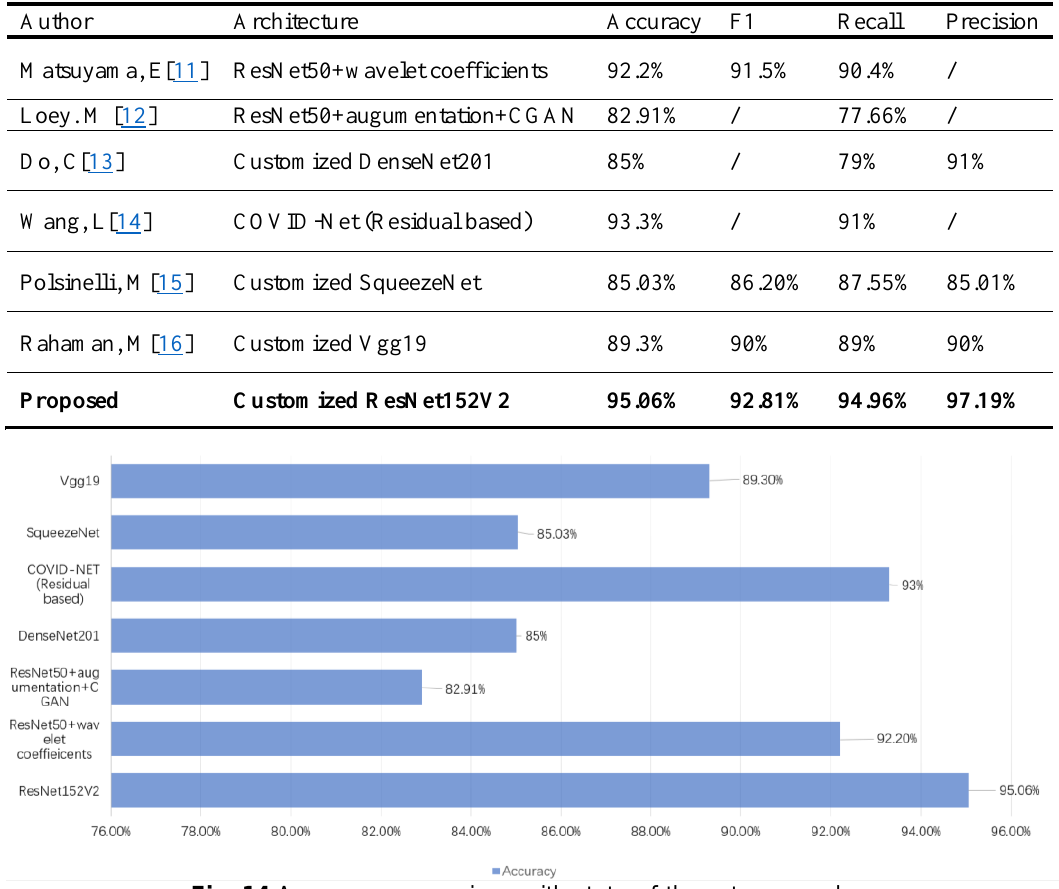
Fig. 14 Accuracy comparison with state-of-the-art